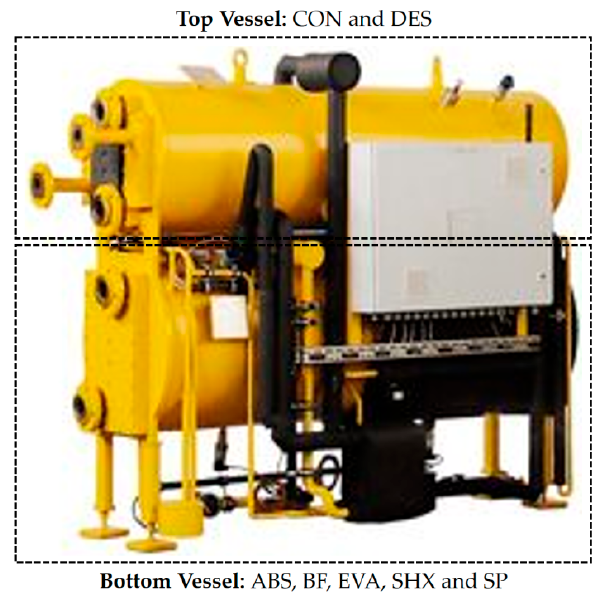
Figure 3. The single-e ff ect water / LiBr absorption heat pump machine with a 50 kW cooling capacity, model “Bee”, from W. Baelz & Sohn GmbH & Co. Adapted from Reference [26]. Note: ABS = absorber; BF = base frame; CON = condenser; DES = desorber; EVA = evaporator; SHX = solution heat exchanger; SP = solution